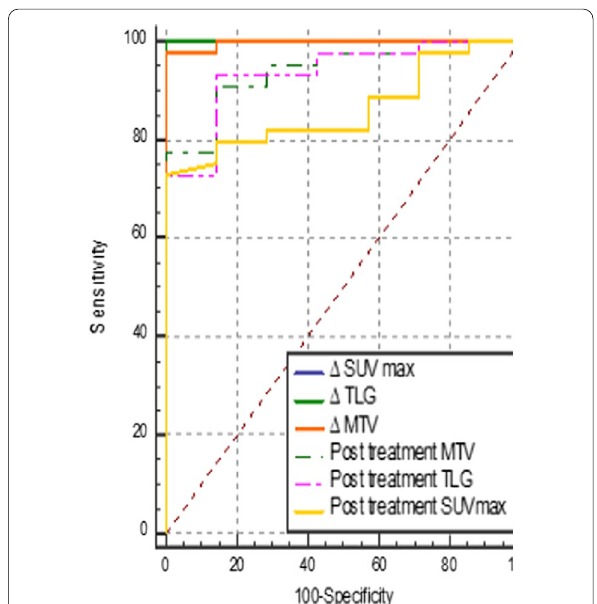
Fig. 1 ROC curve analyses of the specificity and sensitivity of using ∆ SUV, ∆ TLG, ∆ MTV, post-treatment MTV, post-treatment TLG and post-treatment SUV in differentiating responsive and non-responsive